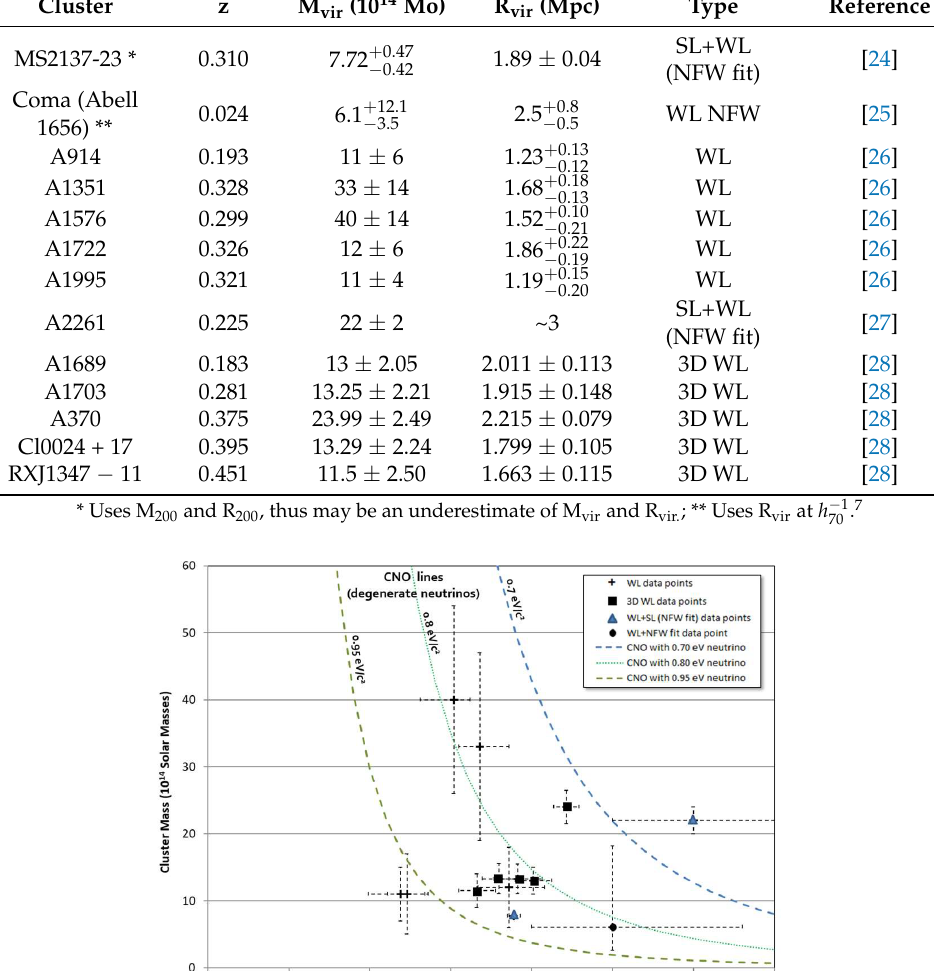
Table 4. Identified weak lensing data and two data points from weak lensing and strong lensing data which used an NFW density fit.